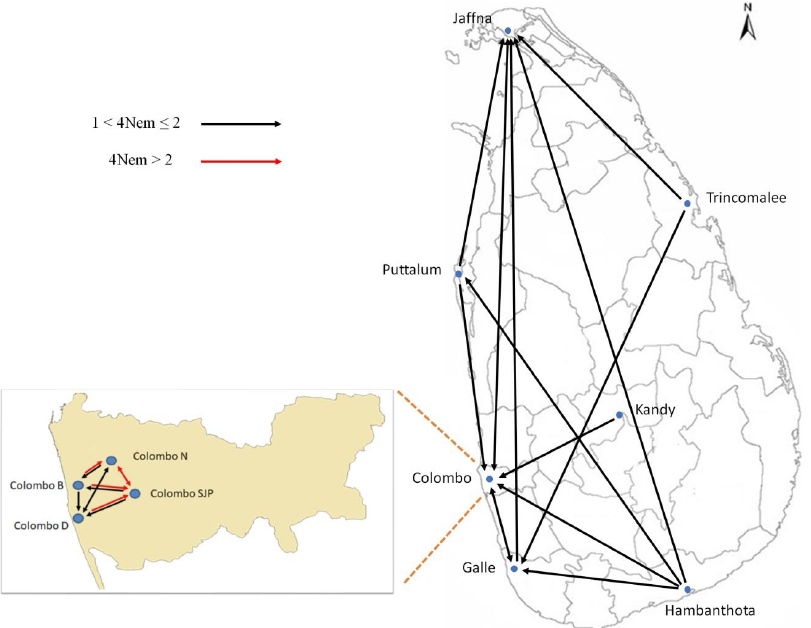
Figure 6. Location of Ae. aegypti collection sites in Sri Lanka and estimated patterns of gene flow among these sites. Blue dots indicate the sampling sites and light gray lines indicate the district boundaries on the map. The arrows in the diagram indicate the rate (4N e m) and direction of the gene flow among the collection sites as estimated by MIGRATE-n 3.5.1. A significant migration rate is indicated by a black arrow where 4N e m > 1. A red arrow indicates 4N e m > 2, which is highly significant, and 4N e m < 1 is not indicated as it does not imply sufficient migration between the donor and the recipient populations to offset genetic drift. The inset shows the gene flow between the collection sites in Colombo.